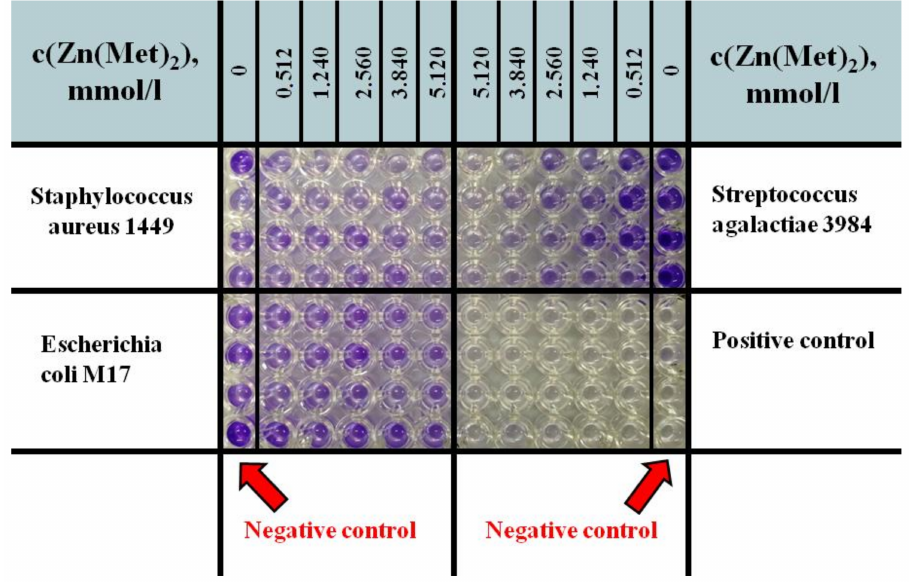
Figure 8. Scheme of antibiofilm activity determination on the example of Staphylococcus aureus 1449, Escherichia coli M17 and Streptococcus agalactiae 3984 bacterial strains: 96-well microtiter plate with 99% ethanol after the solubilization of biofilm-bound crystal